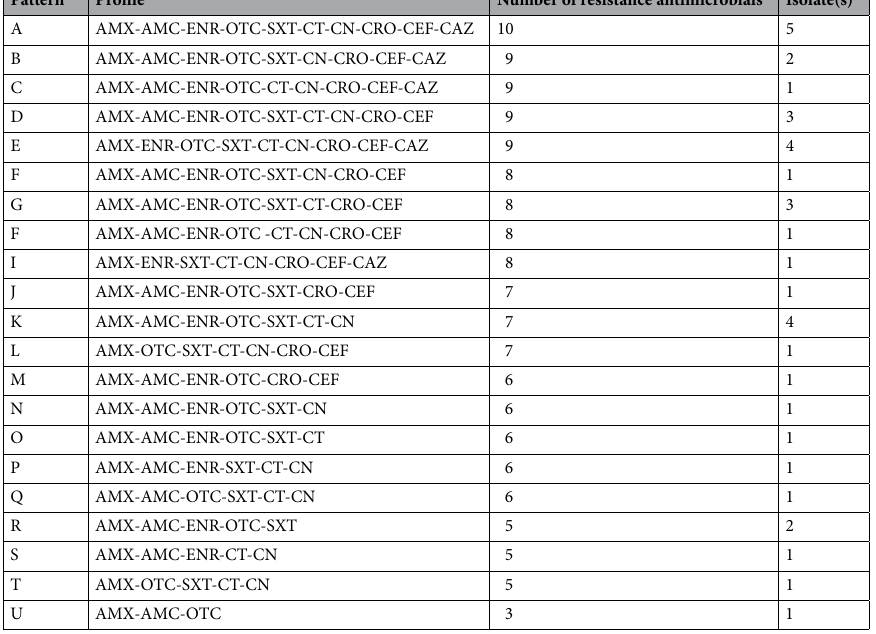
Table 4. PCR results also determined that 28 of 37 (75.7%) isolates carried the int1 gene (Table 1). Almost all int1 -positive isolates (24 isolates) carried the mcr gene and only four int1 -positive isolates did not contain the mcr gene.